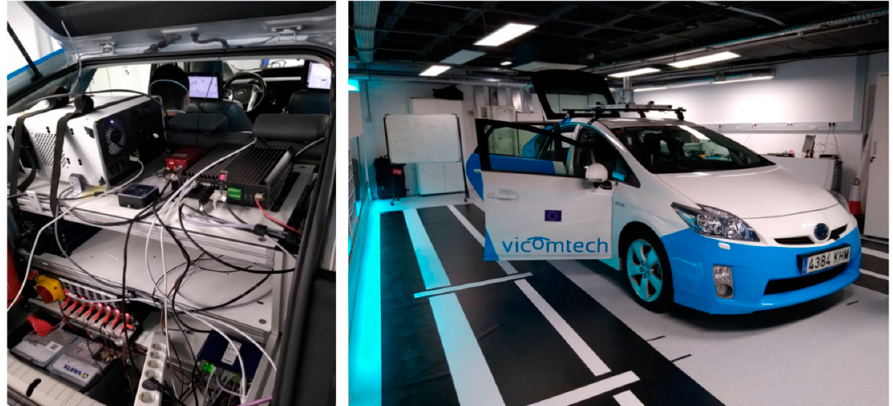
Figure 7. Pictures of our test car, CarLOTA, including a picture of all the equipment installed in the trunk of the car.